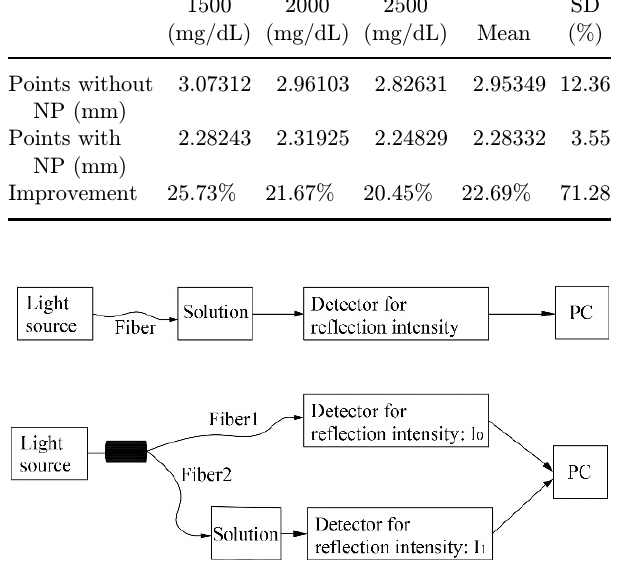
Fig. 11. Schematic of measurement system: (a) traditional measurement system and (b) improved measurement system for reducing the light source